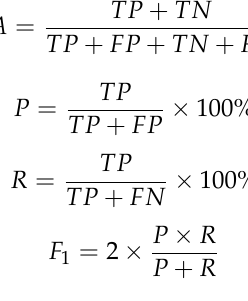
Table 3. Basic training parameters in the experiments.